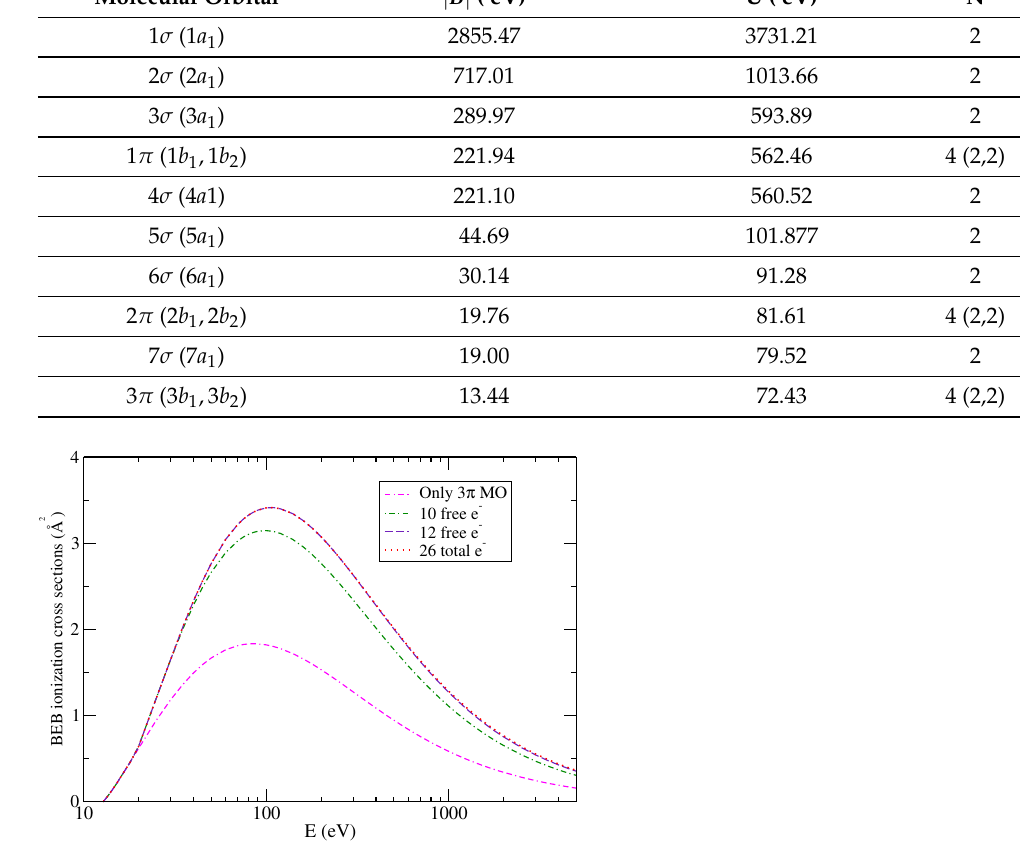
Figure 10. BEB ionization cross section using all electron models by considering different free numbers of electrons: dashed dotted curve, only 3 π molecular orbitals (MO); dotted dashed curve, 10 free electrons; double dashed curve, 12 free electrons; dotted curve, from total 26